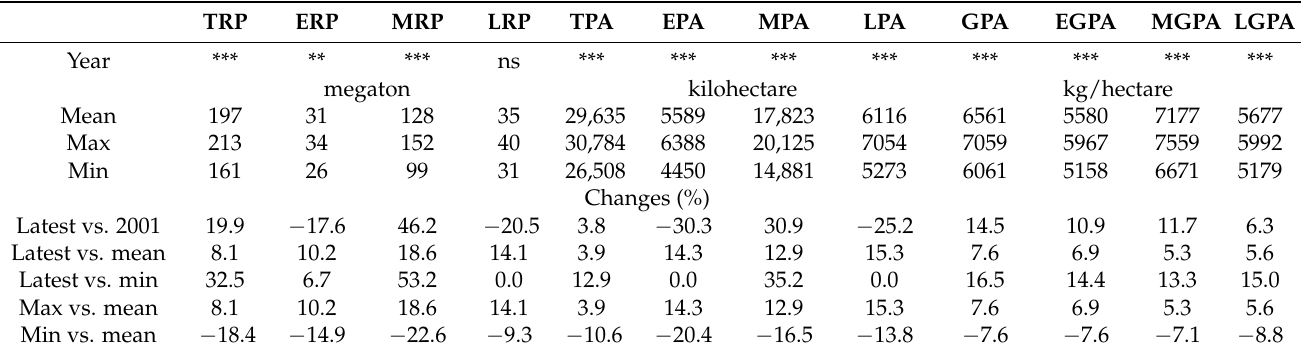
Figure 1. Total rice production (TRP), early rice production (ERP), middle rice production (MRP), and late rice production (LRP) in the recent 20 years. Correlations (r-value) are from ellipse method. Table 2. Mean, max, min, and the changes in rice production, planting area, and grain yield per unit planting area in the recent 20 years.